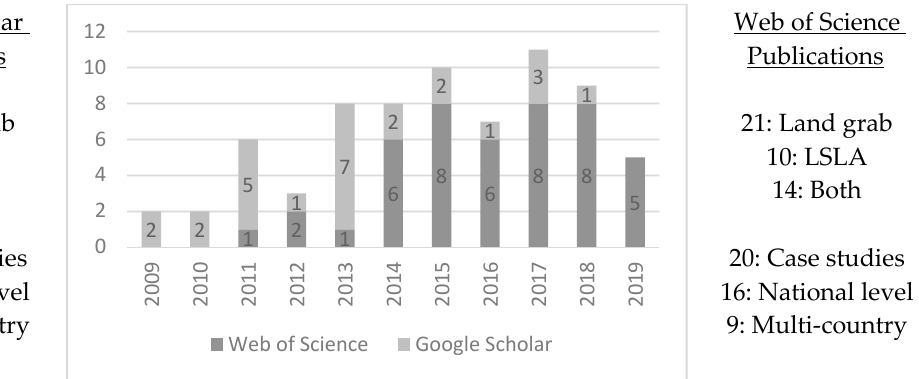
Figure 2. Publication timeline of the dataset (2009–2019).